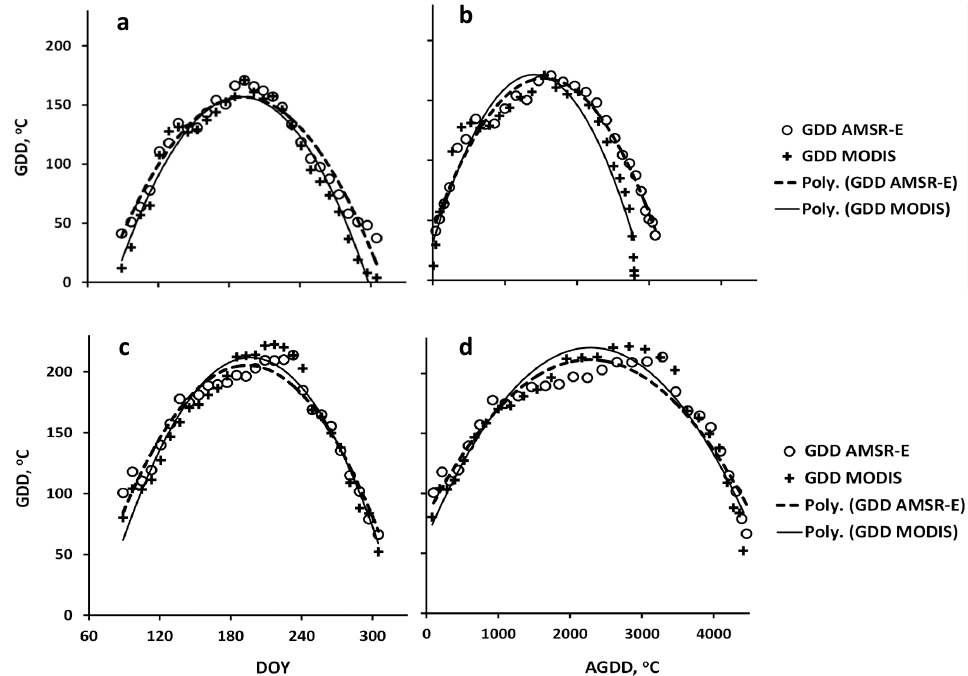
Figure 5. Average (2003–2010) MODIS (plus signs) and AMSR-E (circles) GDD and their fitted (solid (MODIS LST) and dashed (AMSR-E ta) lines) average GDD as a function of DOY ( left ) and AGDD ( right ) for two cropland sites at the latitudinal extremes of the study region: Cheboksary, Russia (site 48, 55.7°N; ( a , b )); and Cherkessk, Russia (site 1, 44.4°N; ( c , d )). N.B.: MODIS GDDs are multiplied by 8, while AMSR-E GDDs are eight-day sums.